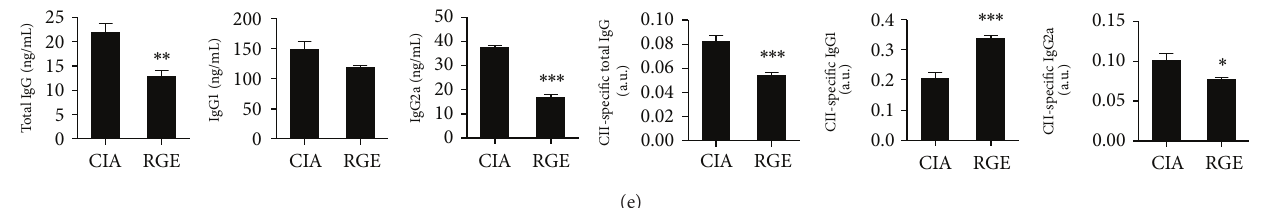
Figure 1: Red ginseng extract suppresses collagen-induced arthritis. Collagen-induced arthritis (CIA) was induced. Mice were orally treated with 10mg/mL of red ginseng extract (RGE) or vehicle only. (a) Clinical scores and incidence of arthritis in CIA-induced DBA/1J mice. (b) Clinical scores and incidence of arthritis in IL-10 KO mice. (c) Representative histological features of the joint of RGE or vehicle-treated mice with CIA. H&E, safranin O, and toluidine blue staining are shown. (d) Representative immunohistochemical staining of the joint of RGE or vehicle-treated mice with CIA (e) Concentrations of CII-specific IgG and IgG2a in sera of RGE or vehicle-treated mice with CIA were determined by ELISA. Data are presented as the mean ± SD of three independent experiments ∗ 𝑃 < 0.05 , ∗∗ 𝑃 < 0.01 , and ∗∗∗ 𝑃 < 0.001 compared to control